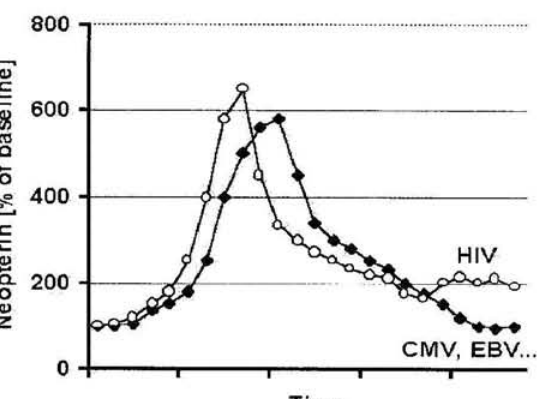
4: Schematic course of serum or urine neopterin concentrations during acute human immun- odeficiency virus (HIV) infection (open circles) as compared with acute infection with other viruses such as cytomegalovirus (CMV) or Epstein Barr virus (EBV) (filled squares). In case of CMV and EBV infection, neopterin concentrations return to baseline upon recovery, in most cases of HIV infection neopterin concentrations remain at a higher level also in the asymptomatic phase after seroconversion. appears to be true for every acute virus infection (58), and it was also observed in, e.g., Ebola virus infections when high concentrations of neopterin in plasma were observed as soon as a few days after the disease onset and were indicative of a fatal outcome (59). By con- trast, in HIV infection, neopterin concentrations increase during acute infection and decline after sero-